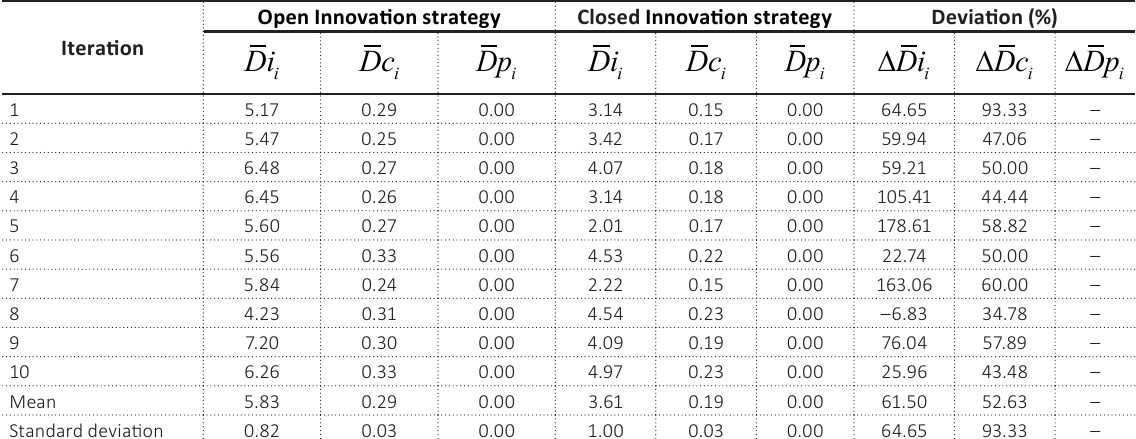
Table 3. Criteria for the effectiveness of organizational structure of 12 subjects (actors, agents) of healthcare institutions from the standpoint of the Open Innovation or Closed Innovation cooperation